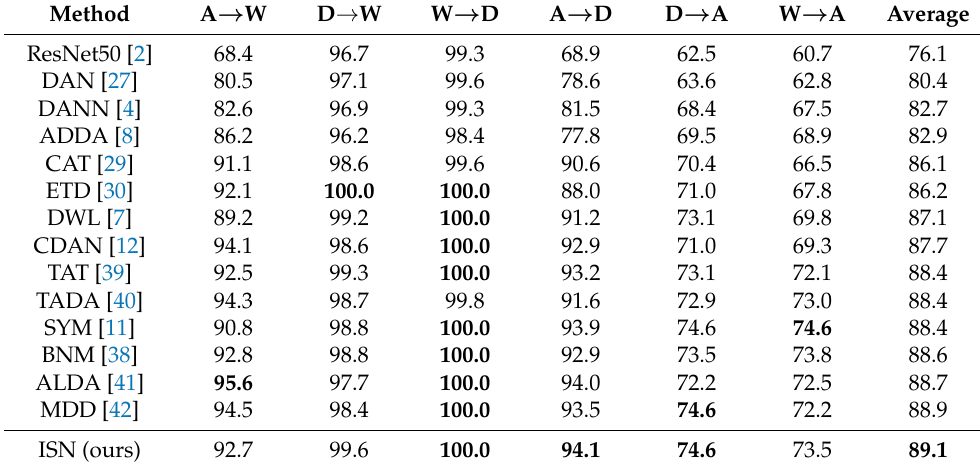
Table 4. Accuracy (%) on